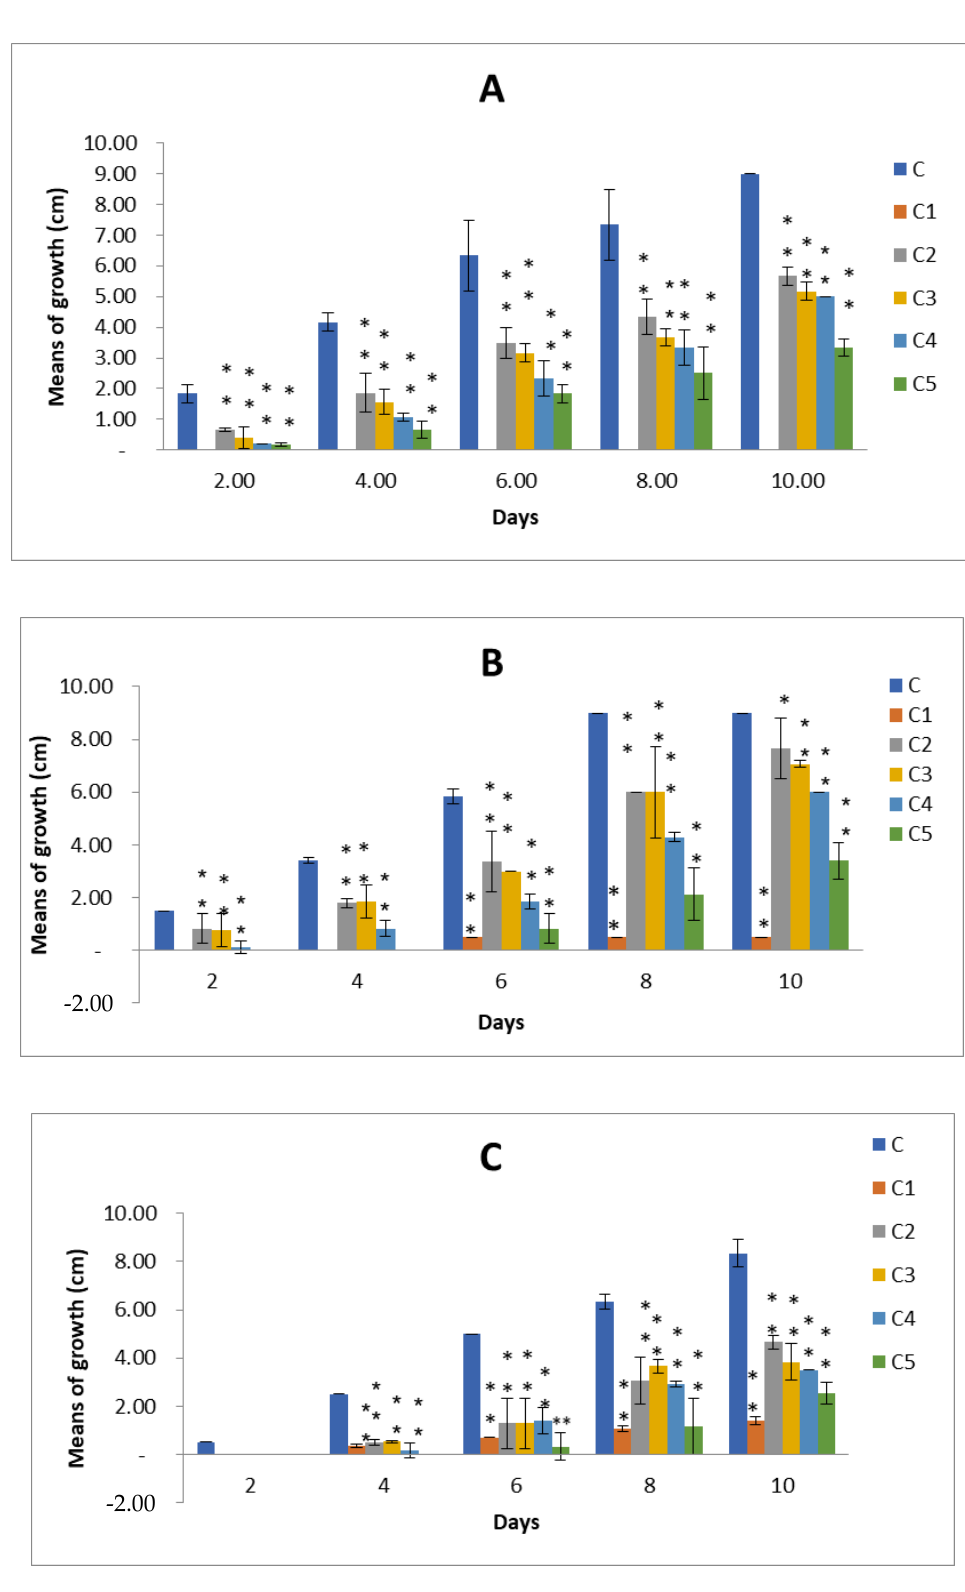
Figure 3. Antifungal activity of leaves extracts of Zizyphus spina-christi L. against ( A ) A. alternata , ( B ) A. citri , and ( C ) A. radicina at different concentrations: C is control, C1 Mancozeb, C2 50 mg/mL, C3 100 mg/mL, C4 150 mg/mL, and C5 200 mg/mL. Values are means of three replicates ± standard deviation. Statistical significance of differences compared to control: * Significant at p > 0.05, ** Significant at p < 0.01 according to Duncan